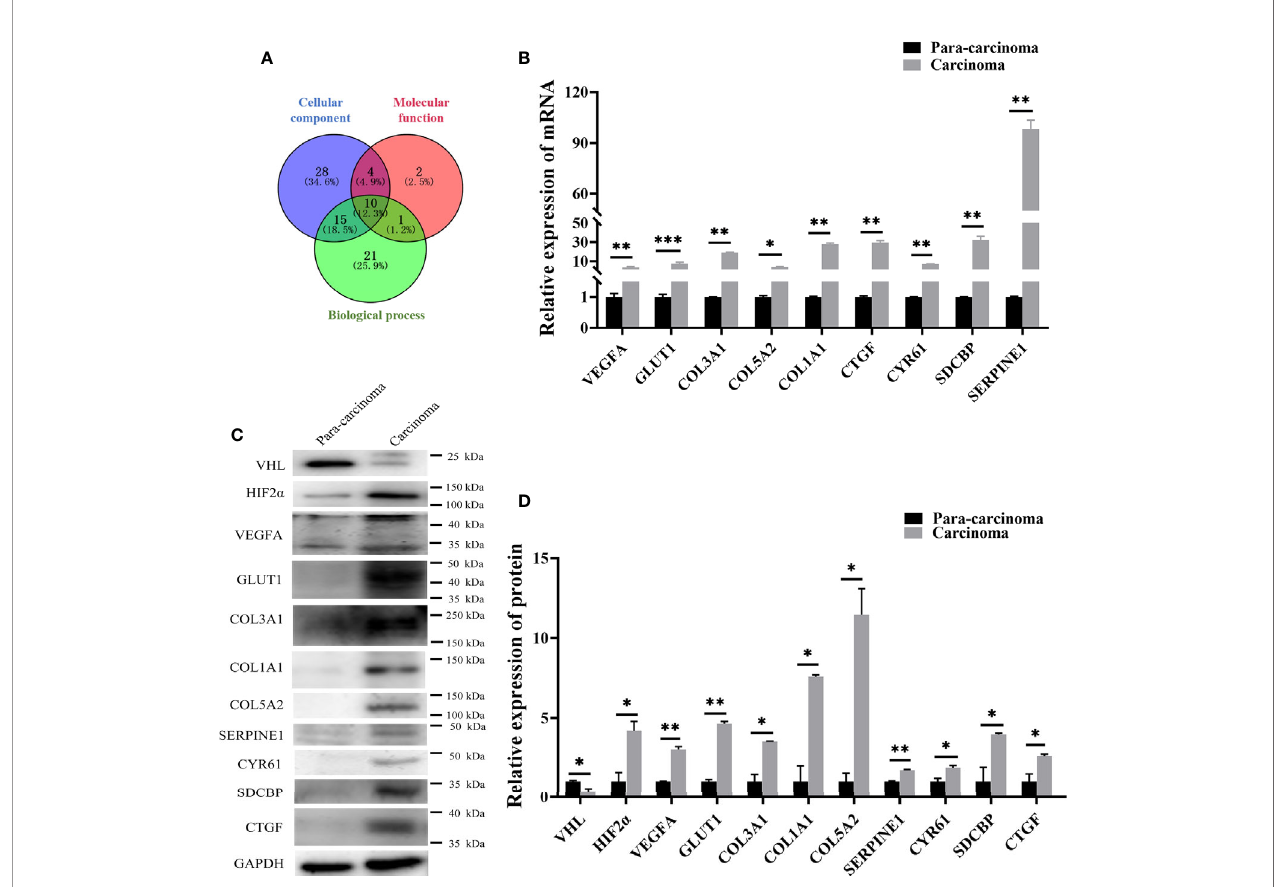
FIGURE 4 | qRT-PCR and western blot con fi rmed that seven genes screened by proteomics analysis were also signi fi cantly up-regulated in pheochromocytoma tumors. (A) Venny diagram was used to screen the co-existing proteins among three groups of proteins. (B) qRT-PCR detected expression of seven genes in PCC carcinoma and para-carcinoma tissues. *signi fi cance between carcinoma vs. para-carcinoma group. * P < 0.05, ** P < 0.01, *** P < 0.001, n = 4. (C) Western blot was used to detect protein expression in clinical tissue samples. *P < 0.05, **P < 0.01, n = 4. (D) The histogram obtained by gray analysis showed the relative change of proteins (mean ± SEM), n = 3, *P < 0.05, ** P <